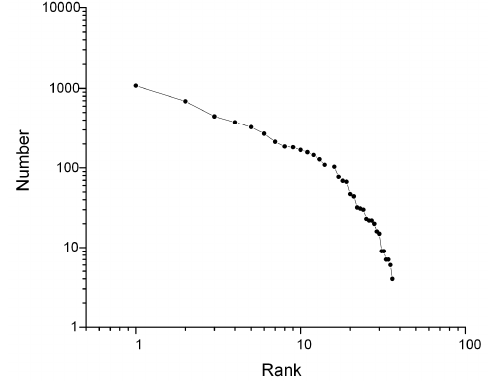
Figure 1. Long tail distribution of the failure numbers.